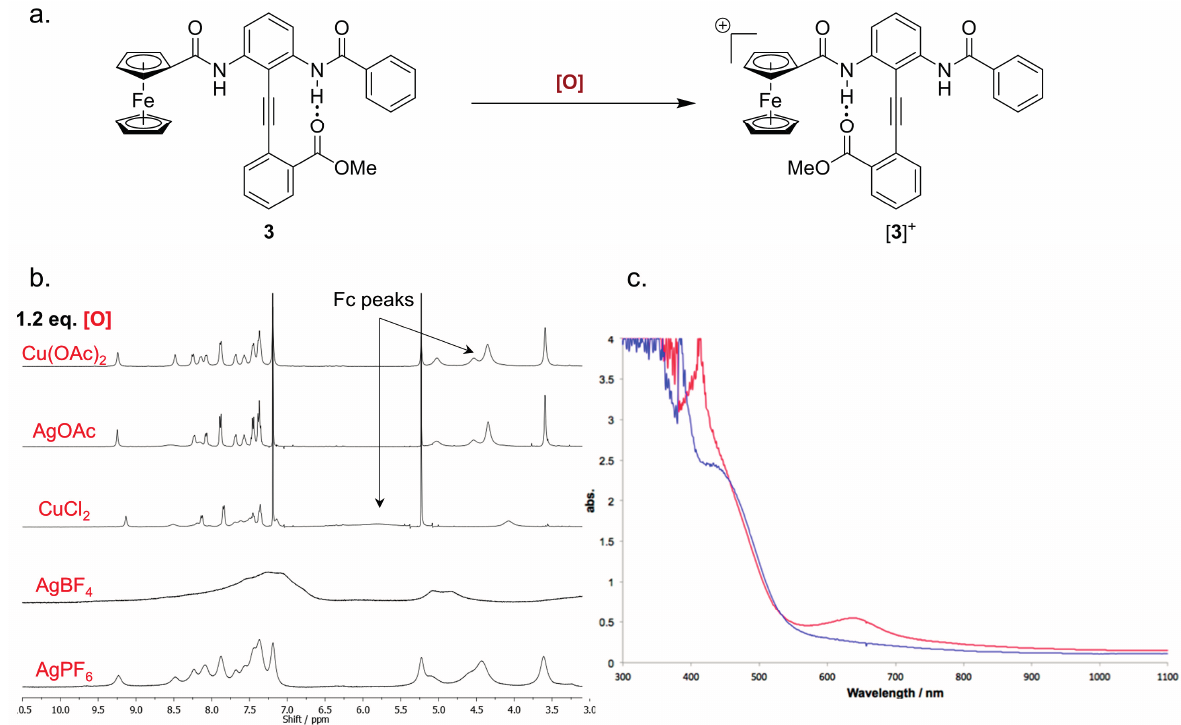
Figure 5. ( a ) Chemical oxidation of 3 to [ 3 ] + ; ( b ) An array of 1 H-NMR spectra acquired after treatment of 3 with various chemical oxidants for 2 h (4.0 mM in CDCl assignments determined by NOE and COSY experiments); ( c ) The UV-vis absorbance spectra of 3 before (blue) and [ 3 ] + after (red) oxidation with CuCl the Experimental Section for further